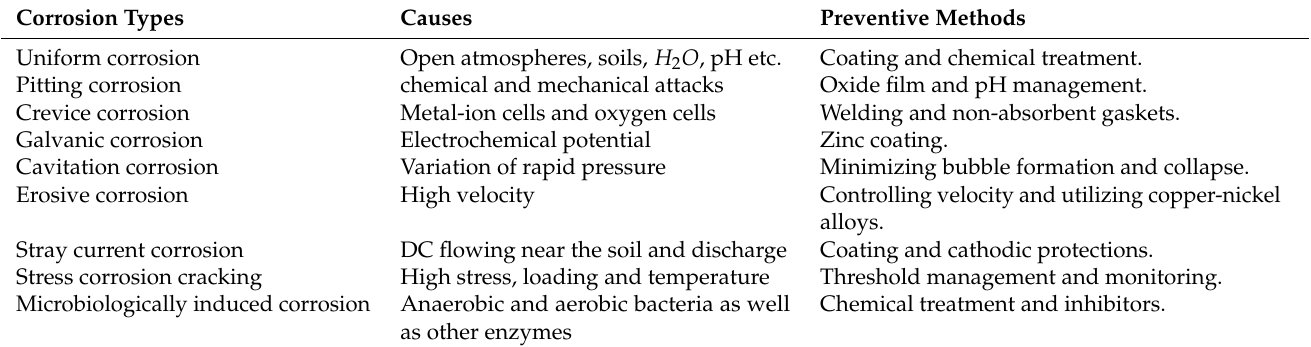
Table 1. A summary of several kinds of corrosion in a carbon–steel pipeline, its causes and preven- tion